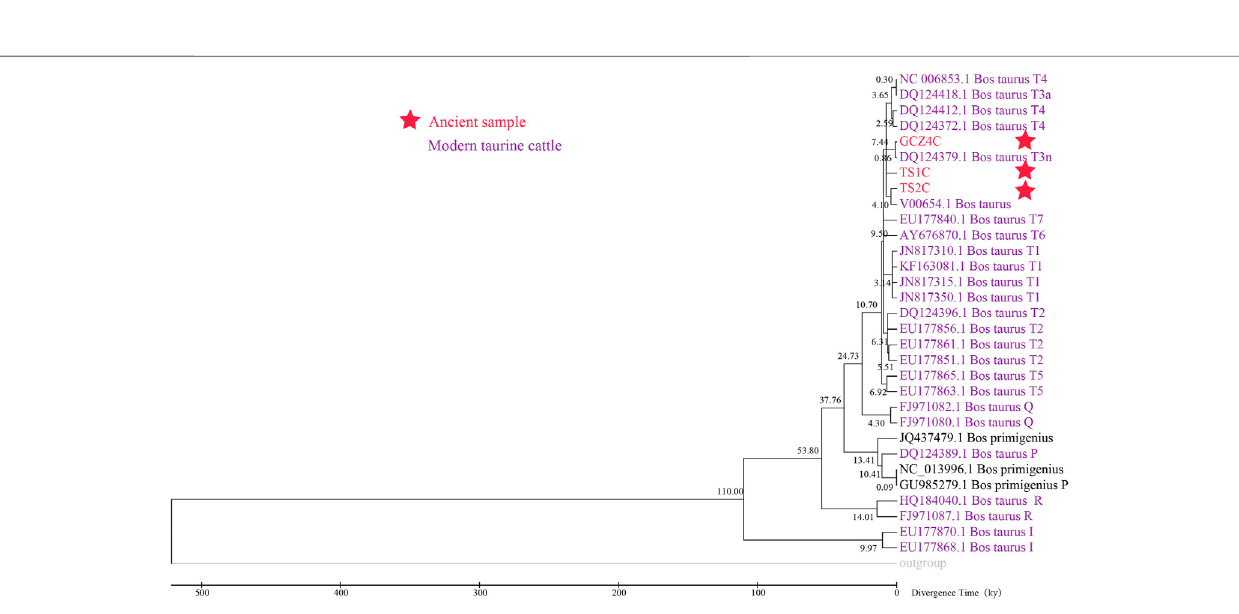
FIGURE 4 | The Bayesian Skyline Plot of ancient and modern Bos . The Y-axis represents the effective number of populations, and the X -axis represents the timeline. The orange line shows the timepoint of effective population decline and the blue line shows the timepoint of the rapid increase of effective population.